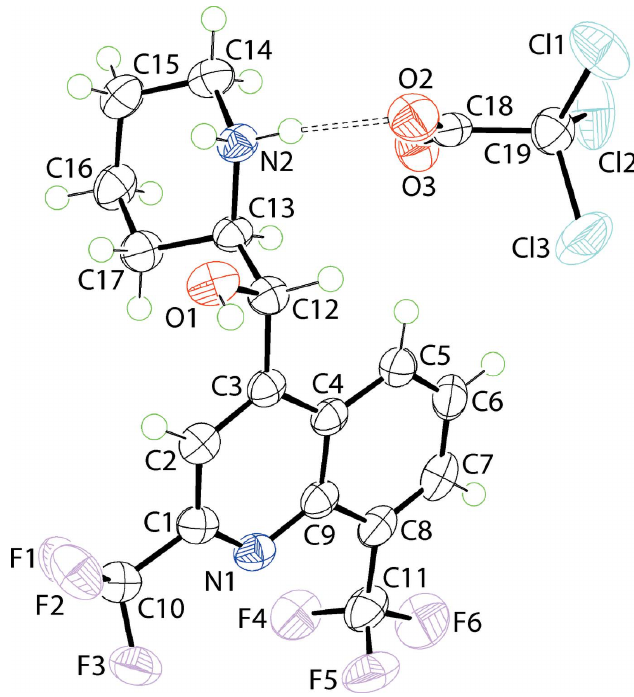
Figure 1 The molecular structures of the two ions comprising the asymmetric unit of (I) showing the atom-labelling scheme and displacement ellipsoids at the 70% probability level. The dashed line signifies an N—H (cid:2)(cid:2)(cid:2) O hydrogen bond.